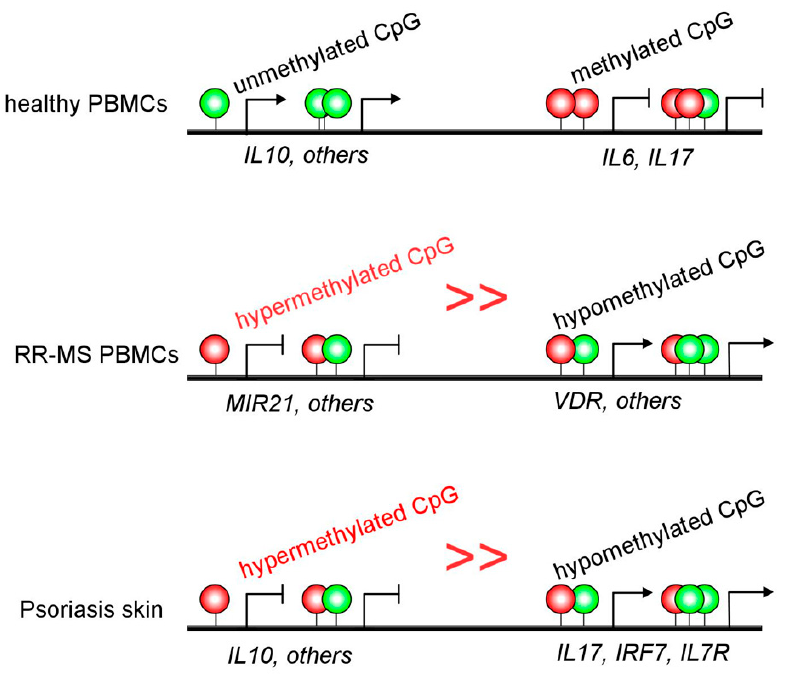
Figure 4. DNA methylation landscape in Relapsing Remitting-MS and Psoriasis autoimmunity. MS and Psoriasis patients carry an altered DNA methylation status, including hypomethylated (green circles) and hypermethylated (red circles) CpG sites. Most of the DMG/DMS seen in MS and Psoriasis display a hypermethylated pattern that may positively correlate with active disease and not often with gene expression. Hypomethylated (green circles) genes are also seen in both MS and Psoriasis. Although several genes, such as IL17 , IRFs , MIR s, and VDR , have been proposed as epigenetics biomarkers for MS and Psoriasis, definitive validation is needed.